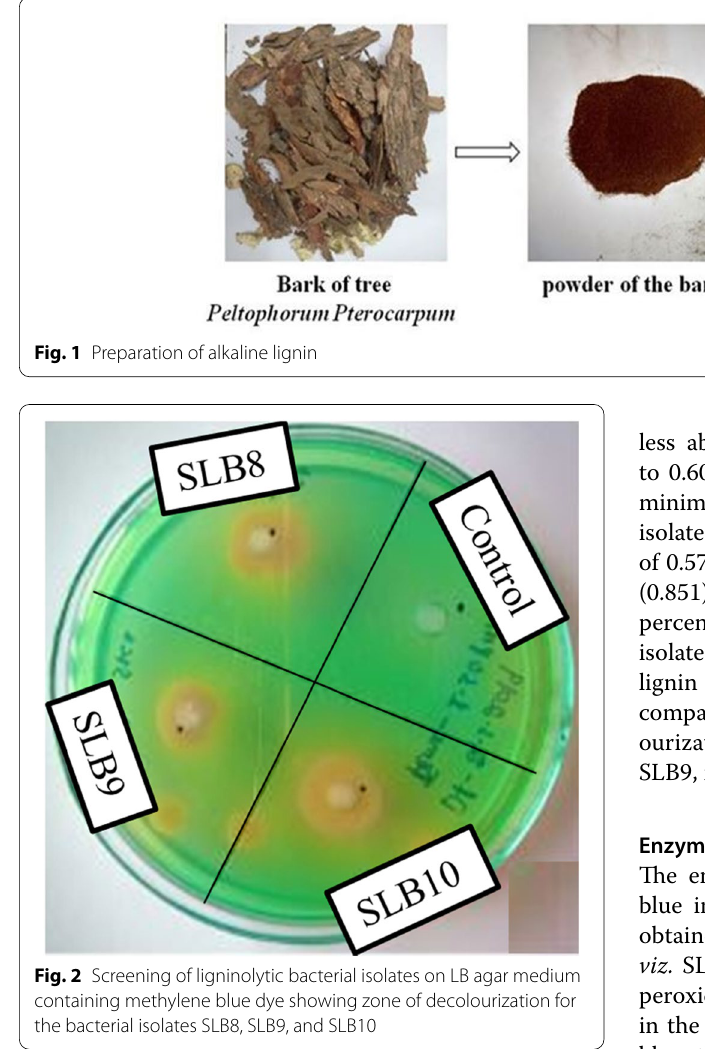
SLB10 with a value of 1.38 followed by SLB9, SLB8, and SLB1 with H to C values of 1.36, 1.33, and 1.21, respec- tively. The range of the H to C values recorded for the ligninolytic bacteria was between 1.05 and 1.38.